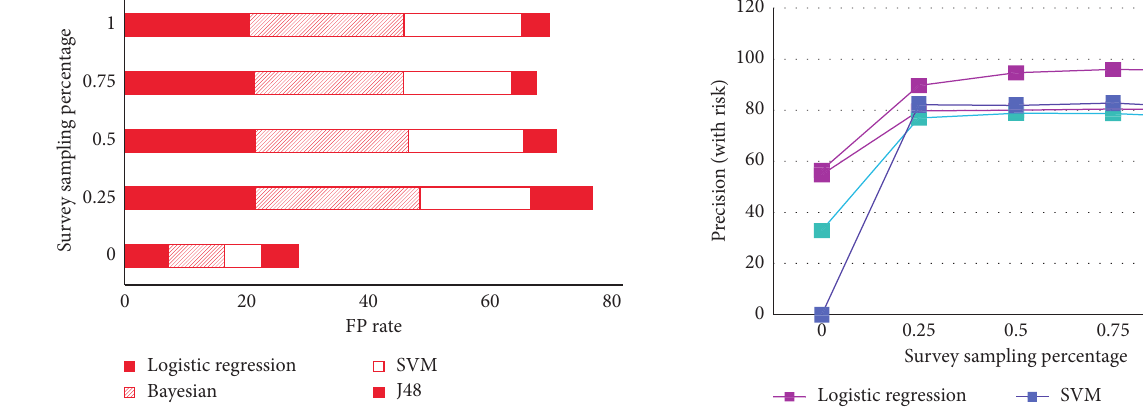
Figure 5: False positive rate comparison.